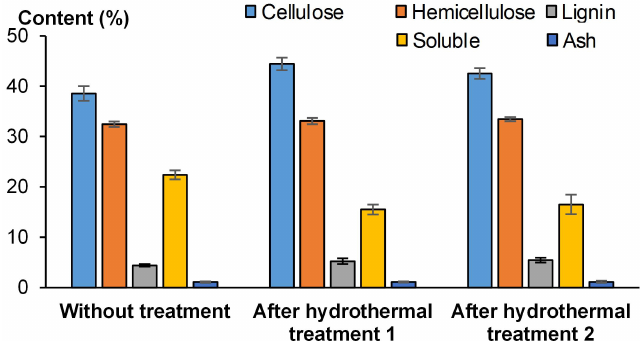
Figure 6. Chemical composition of wheat straw without treatment and after hydrothermal treatments 1 and